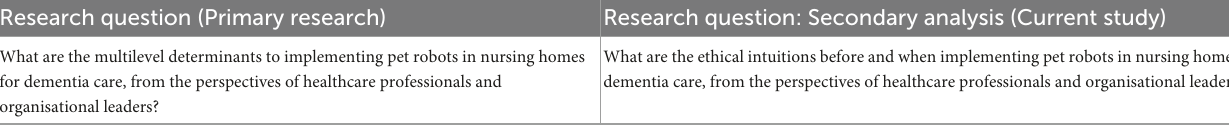
TABLE 2 Research questions in primary research and current